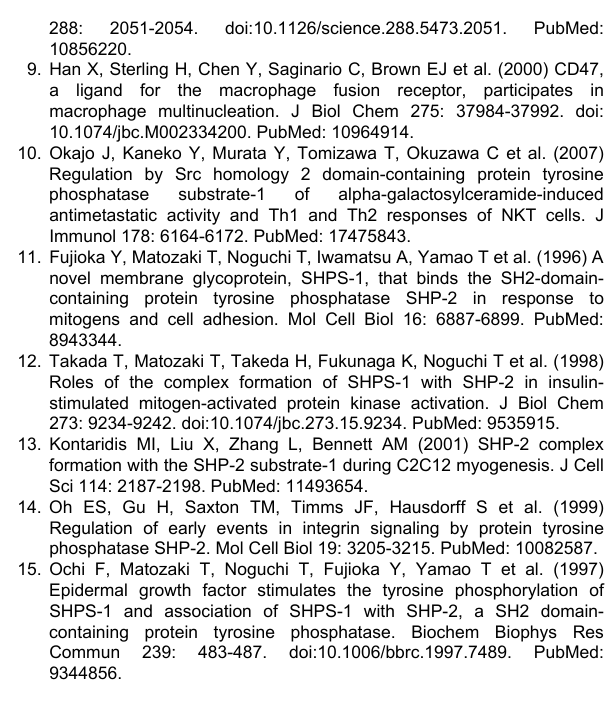
Figure S2. Schematic depiction of monocyte transmigration. HMEC-1 cells were cultured on the transwell filter (with 5 μm pore size) until confluency. For monocyte transmigration, freshly isolated PBMC were added to the upper